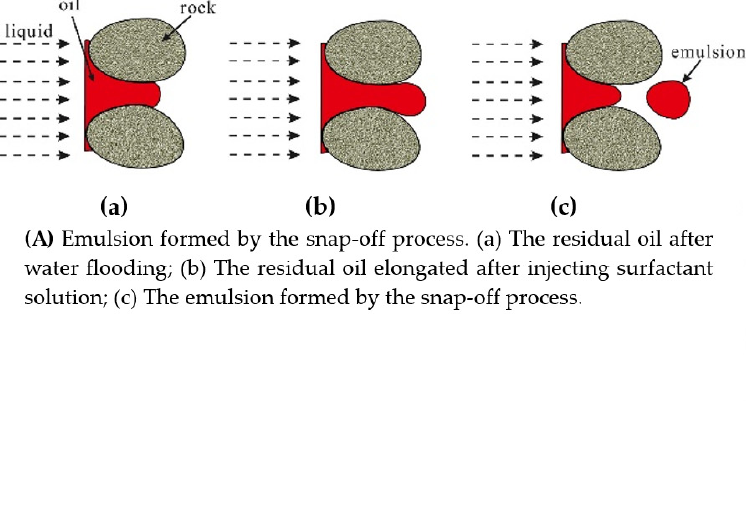
Figure 4. The formation of O/W emulsions by the shearing mechanism.